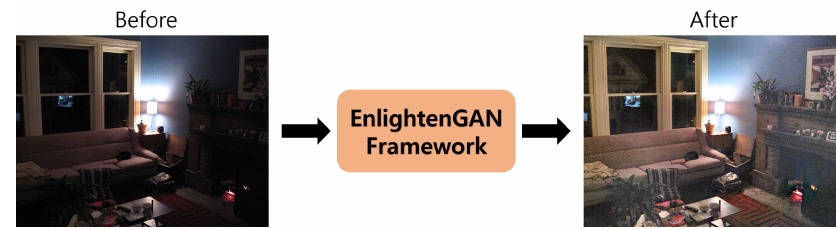
Figure 9. Example of images in the furniture domain reconstructed by